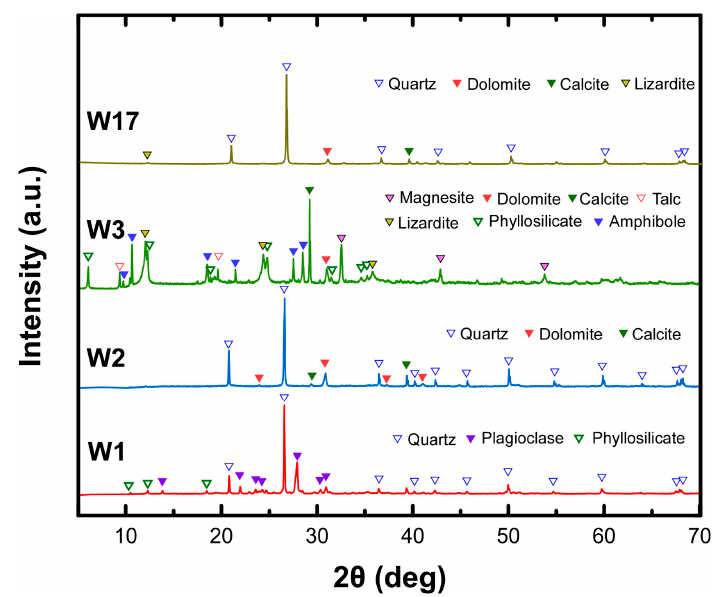
Figure 2. XRPD patterns of listvenite (W1, W2, W17) and clayey serpentinite (W3) samples. The phyllosilicate in sample W1 is mica whereas in sample W3 it is chlorite.